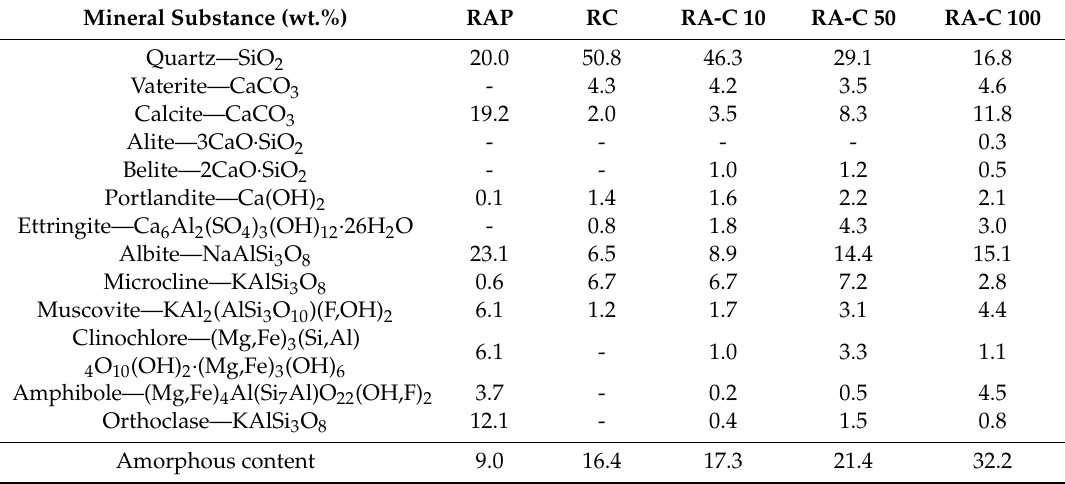
Table 7. Mix proportions of RC and RAP derived